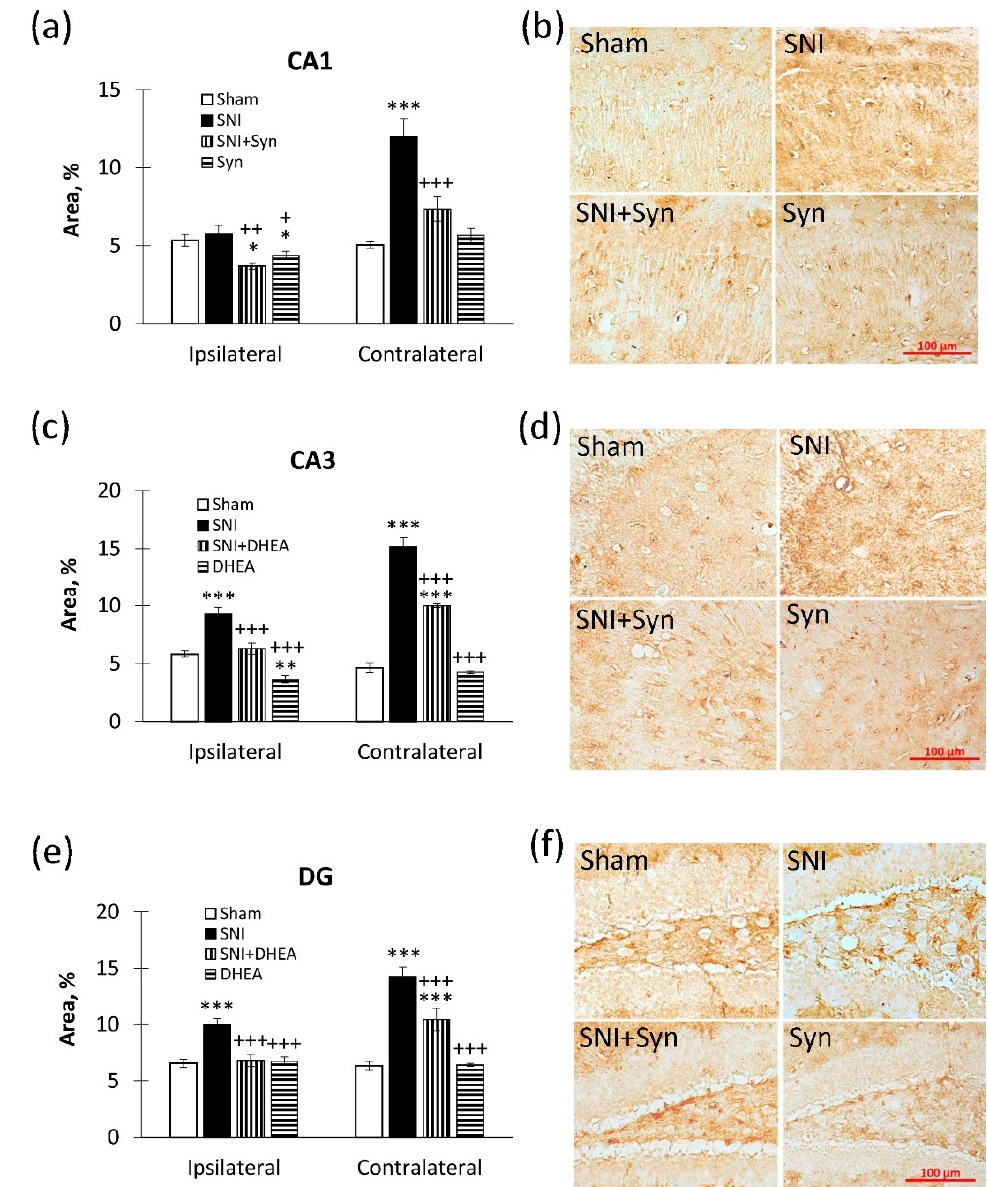
Figure 5. CD86 immunoreactivity in CA1, CA3 and dentate gyrus (DG) hippocampal regions. ( a ) The percentage of CD86 immunopositive staining area in CA1 hippocampal region. ( b ) Representative images of CD86-positive immunostaining in CA1 hippocampal region. Scale bar—100 µ m. ( c ) The percentage of CD86 immunopositive staining area in CA3 hippocampal region. ( d ) Representative images of CD86-positive immunostaining in CA3 hippocampal region. Scale bar—100 µ m. ( e ) The percentage of CD86 immunopositive staining area in DG hippocampal region. ( f ) Representative images of CD86-positive immunostaining in DG hippocampal region. Scale bar—100 µ m. Two- way ANOVA with post hoc Tukey test, * p < 0.05, ** p < 0.01, *** p < 0.001; + p < 0.05, ++ p <